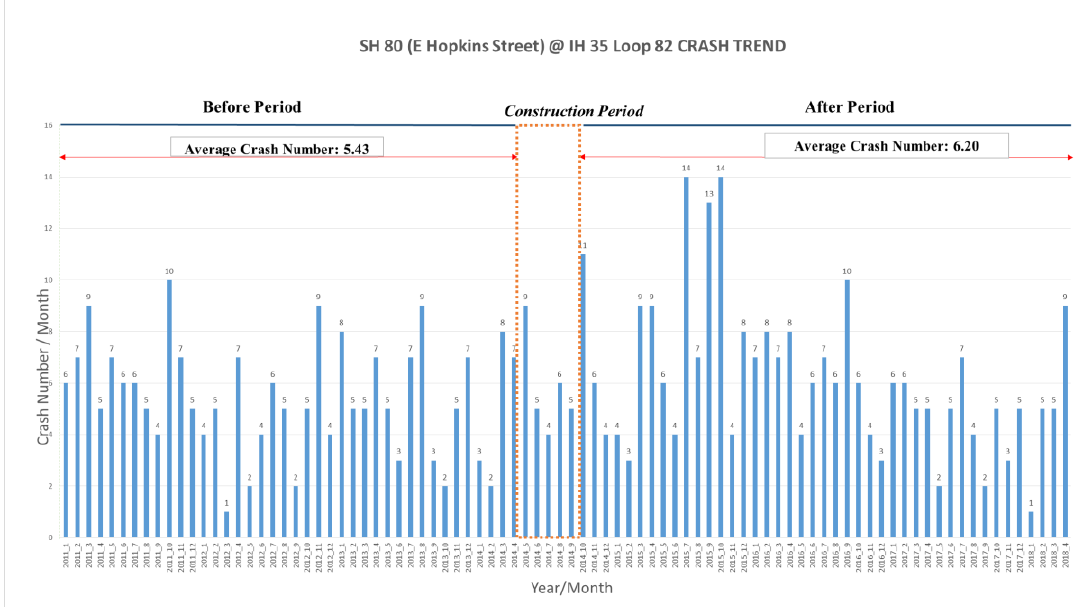
Figure 5. Monthly crash frequency during the study period (January 2011 – 12 October 2014) at Intersection 2 on State highway (SH) 80 (Hopkins Street) at IH 35.